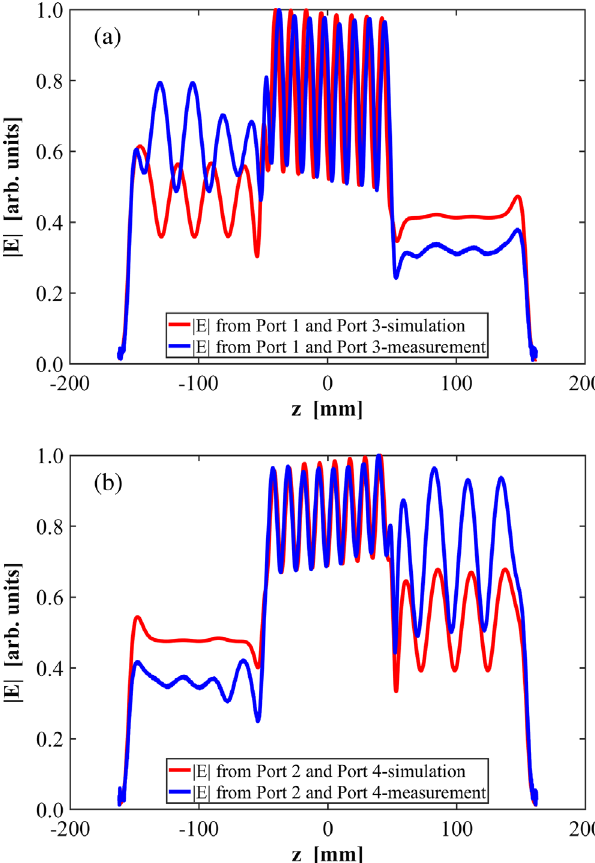
FIG. 26. Comparisons between measured (a) S 0 11 and S 0 22 , (b) S 0 12 and S 0 21 for the full-assembly structure with a sliding distance d ¼ 1 . 0 mm.